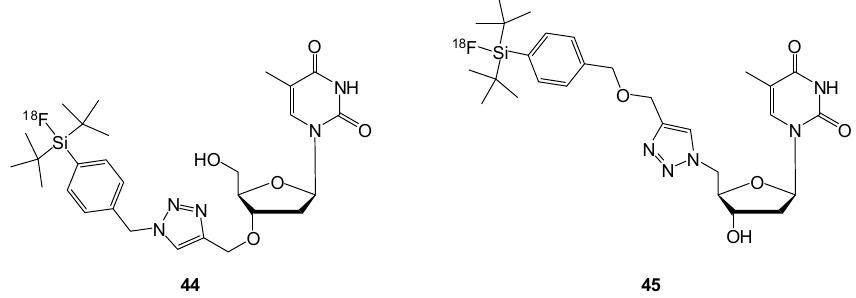
Figure 16. Structures of the 18 F-labeled thymidine derivatives 44 and 45